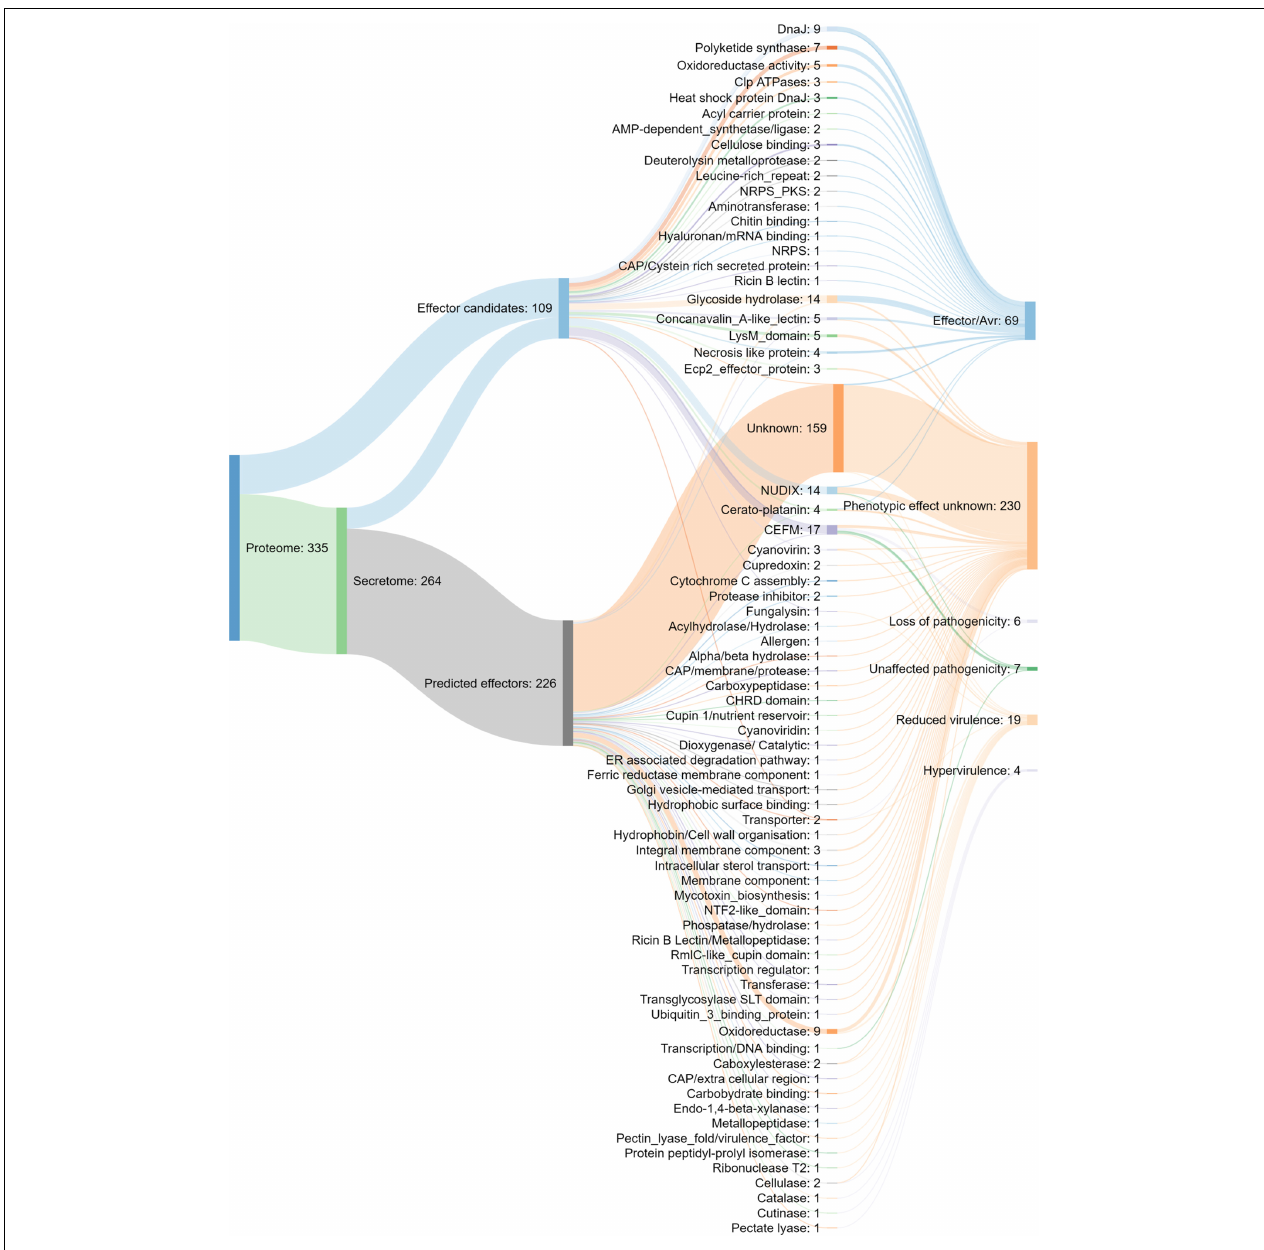
FIGURE 6 | Composition of the putative N. psidii effecterome and predicted effect on the pathogen–host interaction of the putative PHIbase homolog.